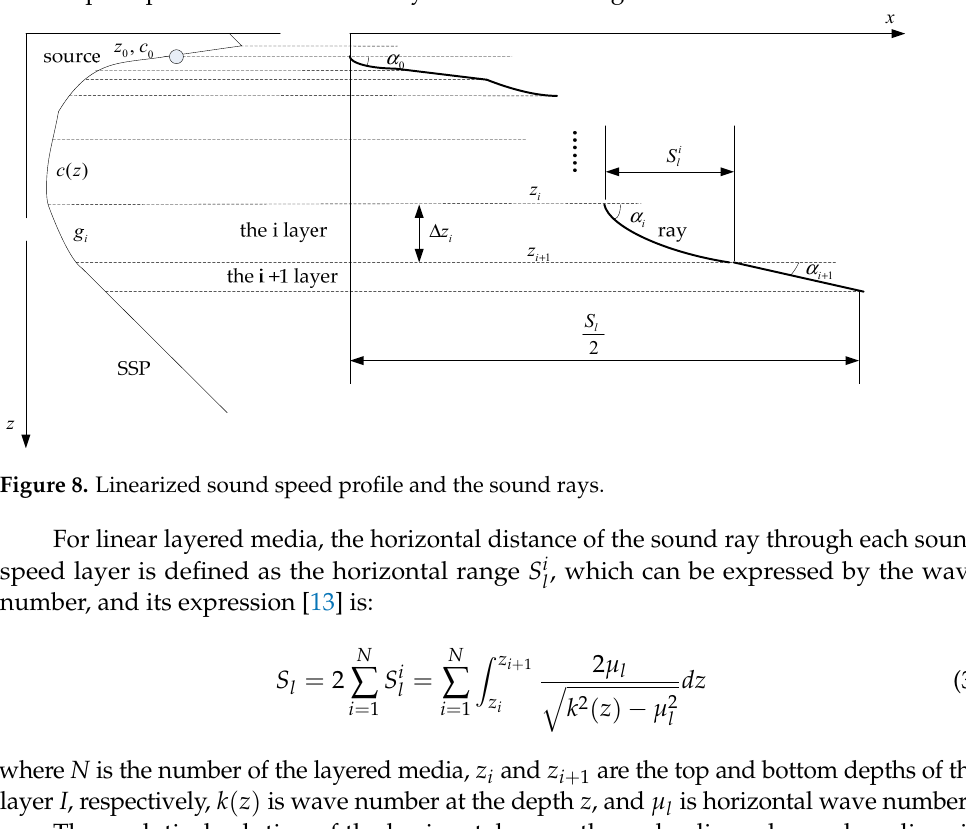
8 of 16 Figure 7. The stratification of the sound speed profile at depth ( a ) and the sound rays ( b ) in the EIO. When a source is close to the surface, according to the Snell law, the sound rays bend toward the vertical. In other words, the sound rays emitted by the source will bend to the bottom. The sound rays will gradually bend toward the surface after passing through the sound channel axis where the sound speed is minimum, where sound speed increases with depth in the deep isothermal layer because of the increase in pressure. When the sound speed near the bottom is greater than that close to the source, some sound rays with small grazing angles do not touch the bottom and reverse upward near conjugate depth. After this process, sound rays converge at the surface to form a CZ. To form a CZ, both the sound source and receiver should be placed in the sound channel, and the water depth should be great enough to reach the conjugate depth. If there is a depth excess in the deep-water waveguide, some deep refracted sound rays do not touch the ocean bottom. These rays are refracted upward to the sea surface and are fo- cused together to form a CZ close to the surface. The sound speed is determined largely by the water temperature. Thus, water tem- perature near the sea surface and the water depth in any particular area will largely de- termine whether sufficient depth excess exists and therefore whether a CZ will occur. Charts of surface temperature and water depth can then be used as basic prediction tools for ascertaining the existence of CZs. As seen in the sound speed profiles in these two ocean areas shown in Figure 3, the sound speed at the source is less than that at the bottom, so CZs will occur in both the EIO